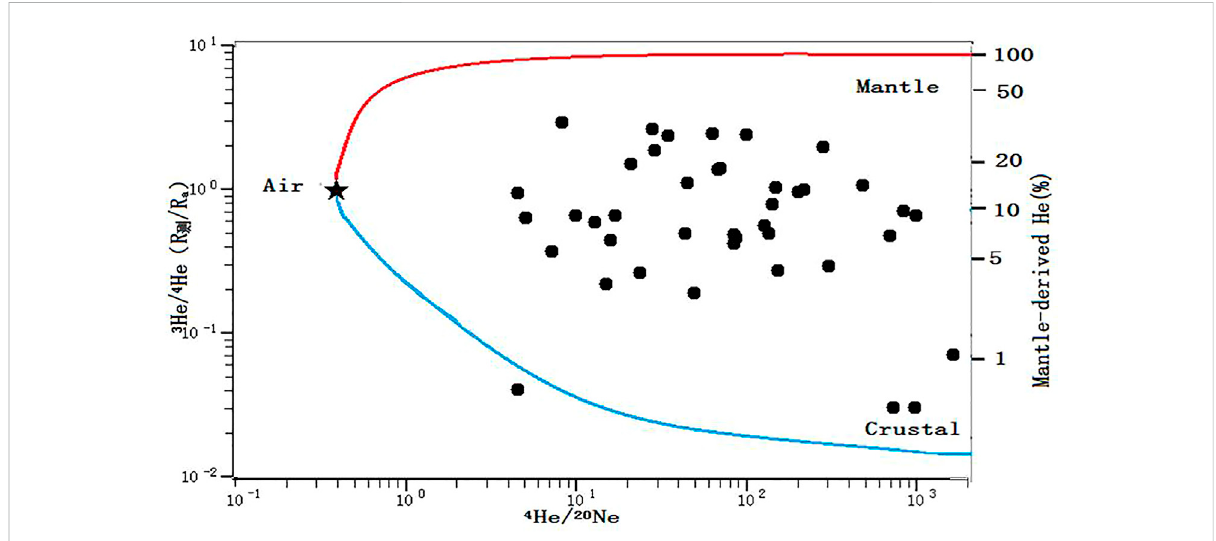
FIGURE 2 Plot of 3 He/ 4 He vs. 4 He/ 20 Ne average ratios in 44 samples of hot spring gas. Mixing lines between the atmosphere and upper mantle and the atmosphere and crust were calculated using the end members: air ( 3 He/ 4 He = 1.4 × 10 – 6, 4 He/ 20 Ne4 = 0.318), upper mantle ( 3 He/ 4 He = 12 × 10 –